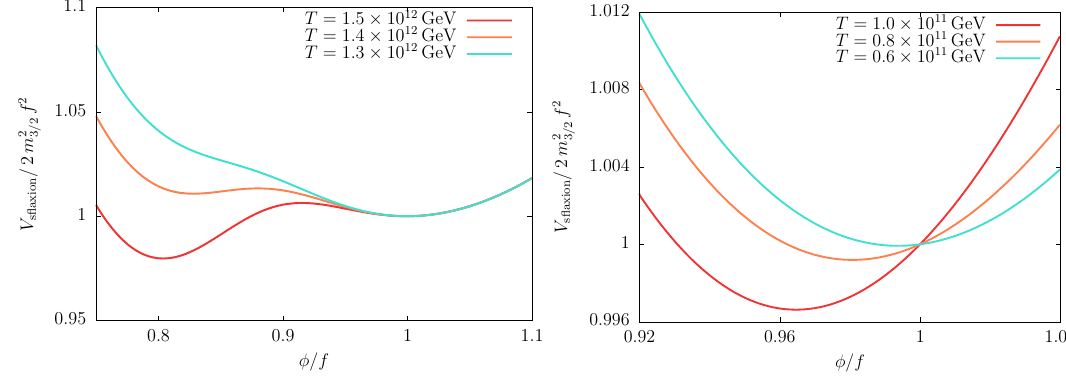
Figure 1 . The changes of the s(cid:13)axion potential with respect to temperature. The cuto(cid:11) scale is set to be M = 10 19 GeV and 10 17 GeV in the left and right (cid:12)gure, respectively. Other parameters are the same: n = 9, y = 1, and m = 10 3 TeV. Here we take V s(cid:13)axion as 3 = 2 m 2 (cid:30) 2 + m 2 f 4 =(cid:30) 2 + V T ( M e(cid:11) ( (cid:30) ) ; T ) (cid:0) V T ( M e(cid:11) ( f ) ; T ). In the left (cid:12)gure, the trapping minimum 3 = 2 3 = 2 disappears as the temperature falls, which induces the s(cid:13)axion oscillation. On the other hand, in the right (cid:12)gure, the trapping minimum and the true minimum are indistinguishable, which means no s(cid:13)axion oscillation. ( y(cid:15) n ) = p m =M ’ 6 and 0.6 in the left and right (cid:12)gure, respectively 3 = 2 (see eq.